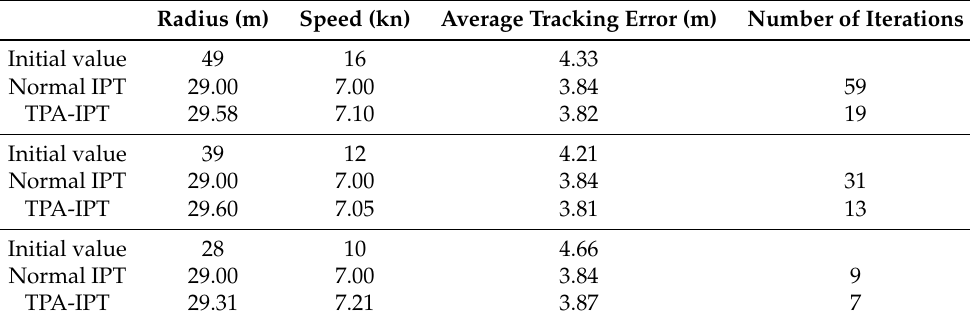
Table 3. Comparison of results with and without an adaptive step length.